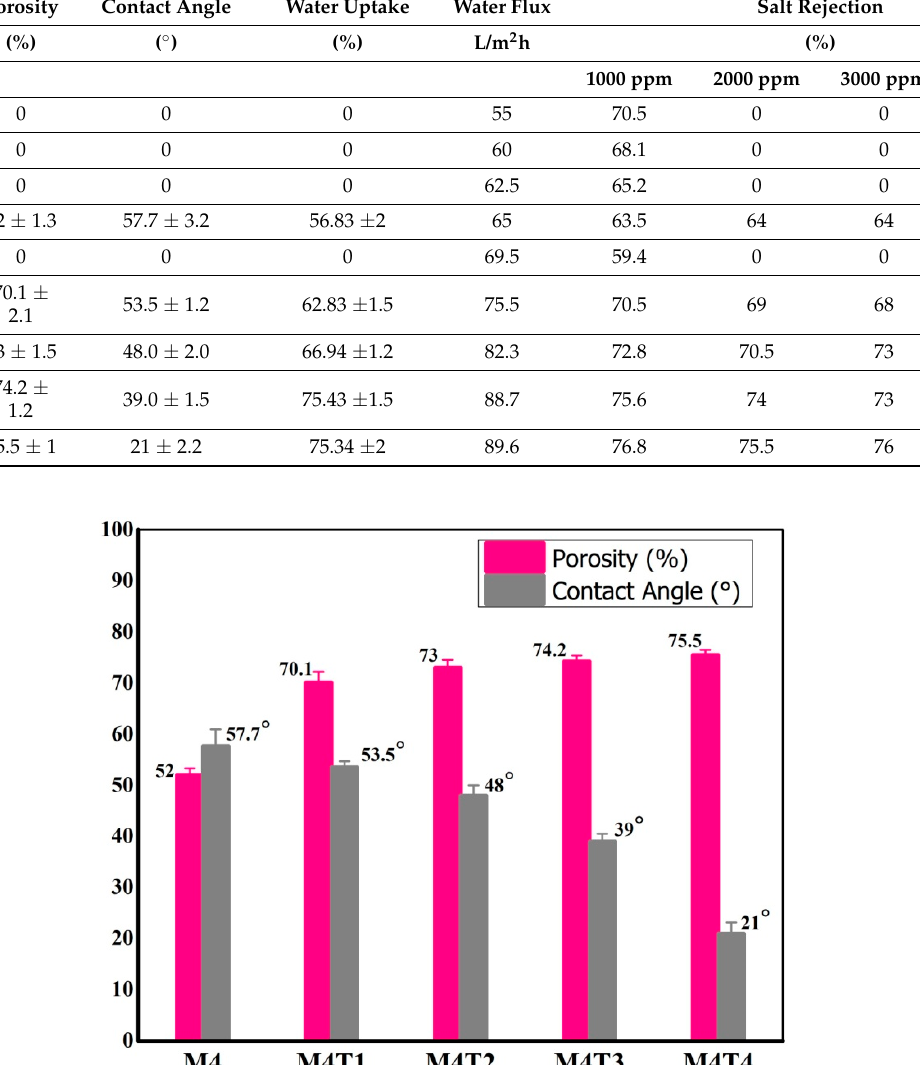
Table 2. TiO 2 /pore former effect on the performance of the pristine membrane and MMNMs.